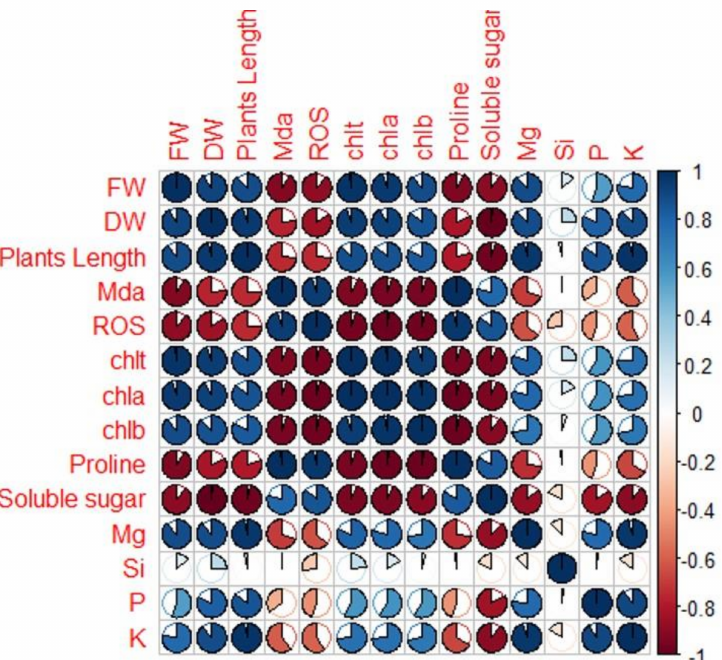
Figure 9. Pearson correlation between different parameters in response to α Fe 2 O 3 NPs treatment under drought stress. Traits included in the analysis are FW (fresh weight), DW (dry weight), PH (plants height), MDA (malondialdehyde), ROS (reactive oxygen species), Chlt (total chlorophyll), Chla (chlorophyll a), Chlb (chlorophyll b), proline, and soluble sugars. The color of the circles and the coefficient values refer to the strength and significance of the correlation: 0.75–1 = strongly correlated; 0.5–0.75 = highly correlated; 0.25–0.50 = moderately correlated; and 0–0.25 = weekly correlated. Under 0 = negatively